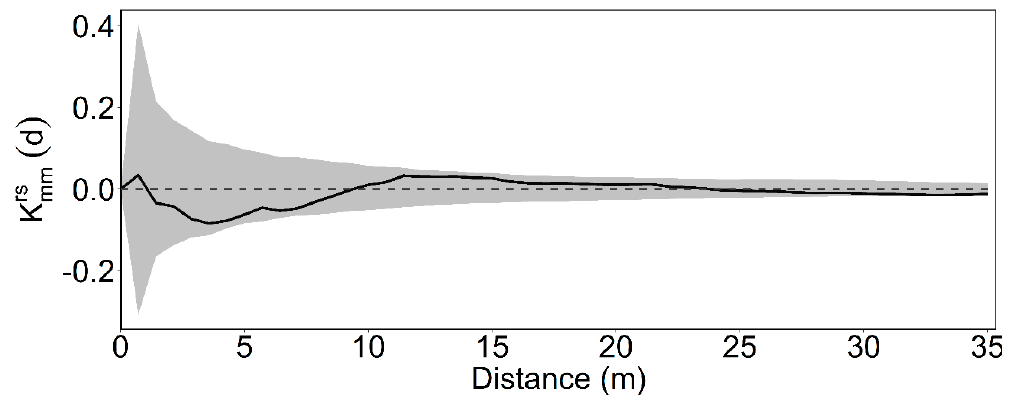
Figure 5. Intertype mark correlation ˆ K rs mm ( d ) function (continuous line) between the diameter at breast height of the adult trees (stems with dbh ≥ 10 cm) and the sapling density (stems with height ≥ 1.30 m and dbh < 10 cm) and the 95% quantile bounds corresponding to the null model.